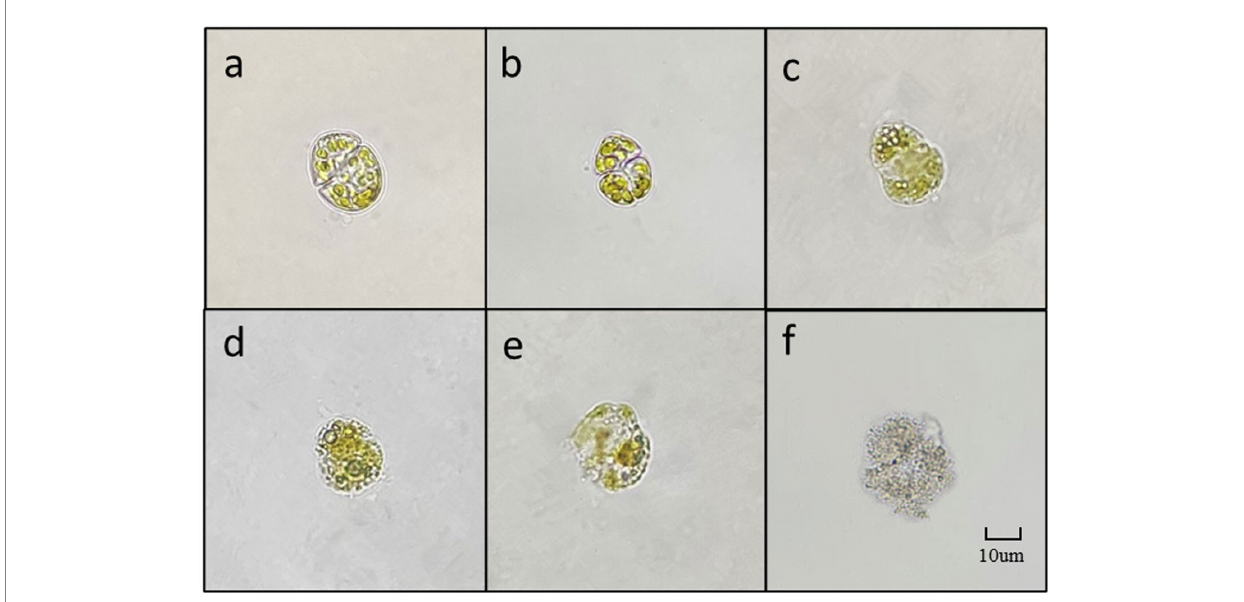
FIGURE 8 The main forms of algae in the algae dissolution process of K. mikimotoi under the influence of Ps3 sterile fermentation broth ( A–F represent different stages of dissolution process, respectively).